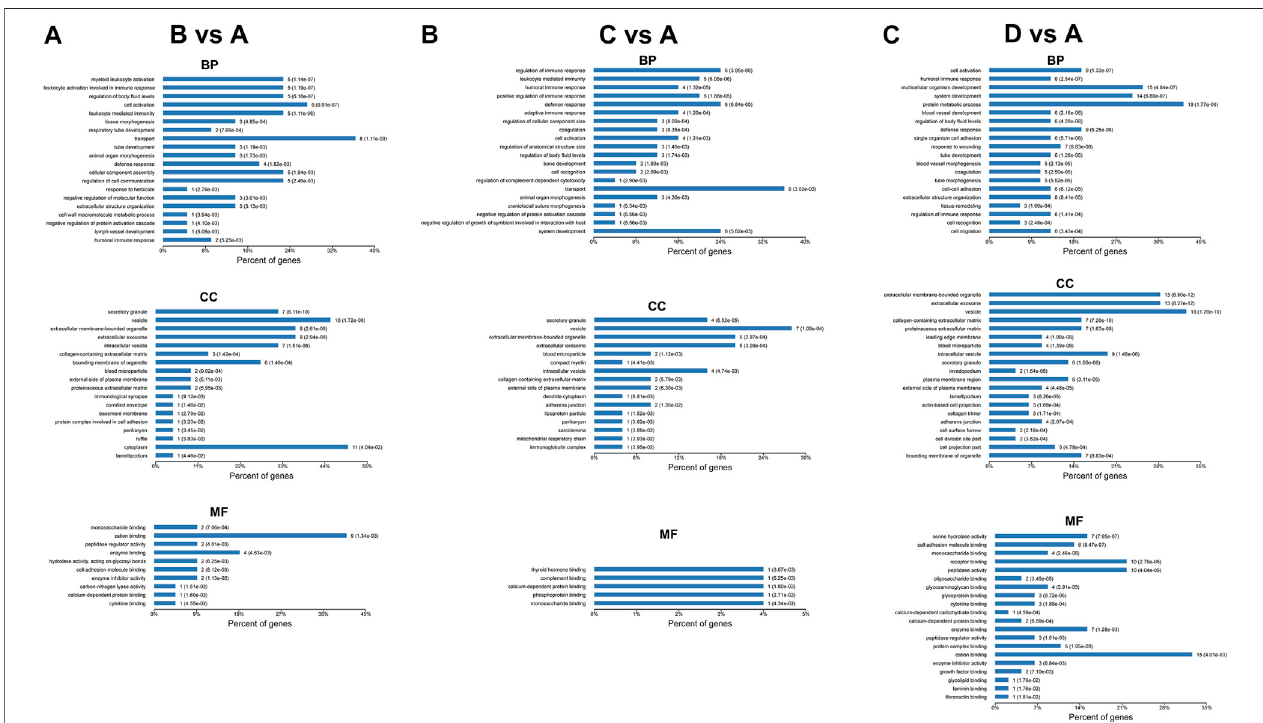
FIGURE 5 | GO enrichment analysis of differentially expressed proteins: (A) group B (mild OSA) vs group A (non-OSA), (B) group C (moderate OSA) vs group A (non-OSA), and (C) group D (severe OSA) vs group A (non-OSA).